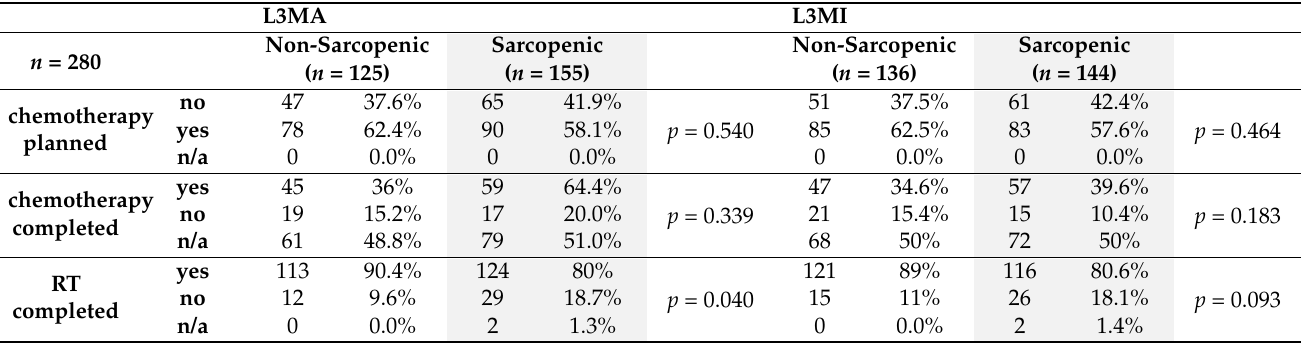
Table 5. Comparison of treatment characteristics for pretherapeutic sarcopenic and non-sarcopenic elderly HNSCC patients undergoing curative (chemo)radiotherapy. p values given for group com- parison with Fisher’s exact tests. L3MA, calculated cross-sectional skeletal muscle area at the third lumbar vertebra; L3MI, calculated skeletal muscle index at the third lumbar vertebra; n , number of patients. L3MA